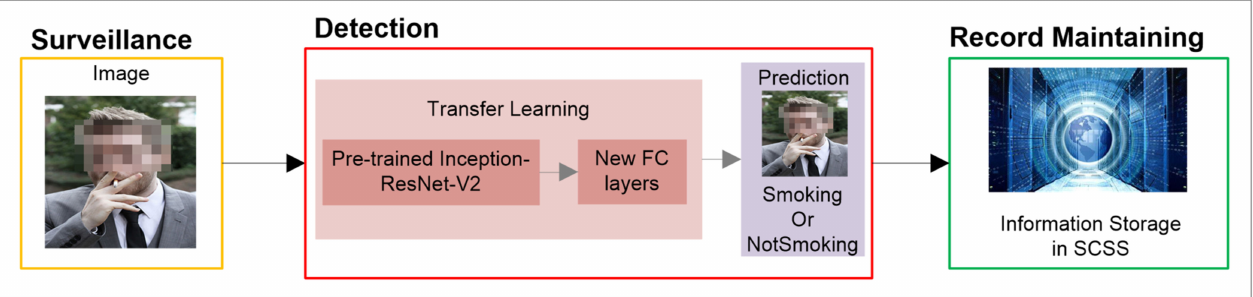
Figure 1. Smoker detection system